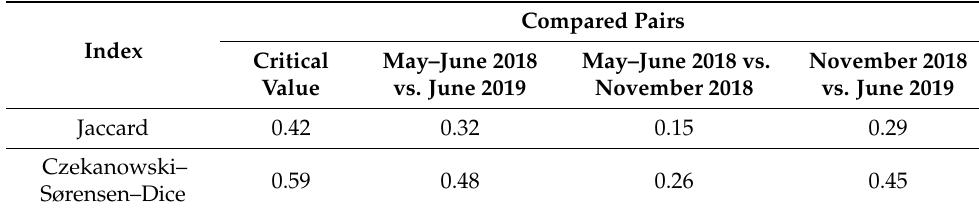
Table 3. Similarity indices between species composition in the different periods (Bay